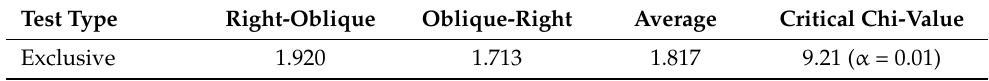
Table 14. Results of chi-test on student’s results by using different strategies.